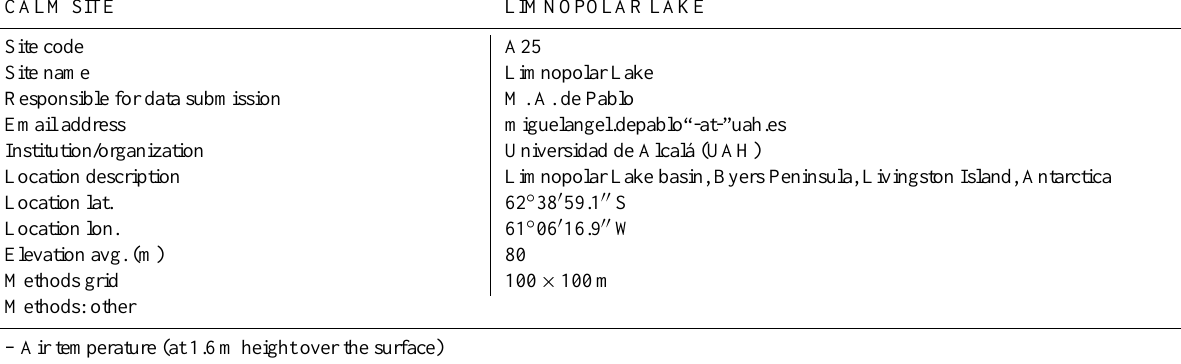
Table A1. Descriptive form of the Limnopolar Lake CALM-S site on Byers Peninsula (Livingston Island, Antarctica), and the monitoring